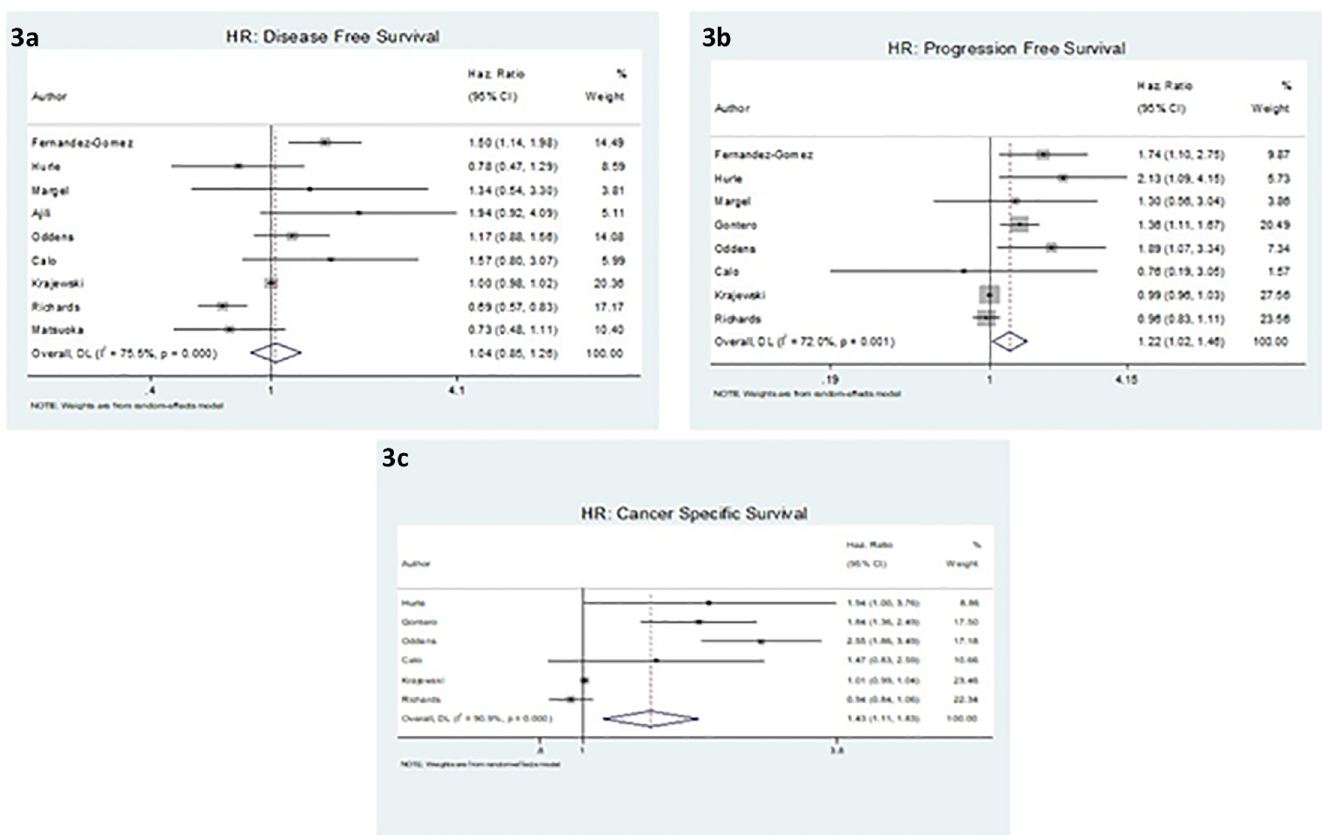
Fig 3. Meta-analysis of the estimated hazard ratios (H.R.s) attributed to age, adjusting for other factors. a: Overall HR of disease-free survival for eight studies (1.08). b: Overall HR of progression-free survival for 8 studies (1.22). c: Overall HR of cancer-specific survival for six studies (1.43).